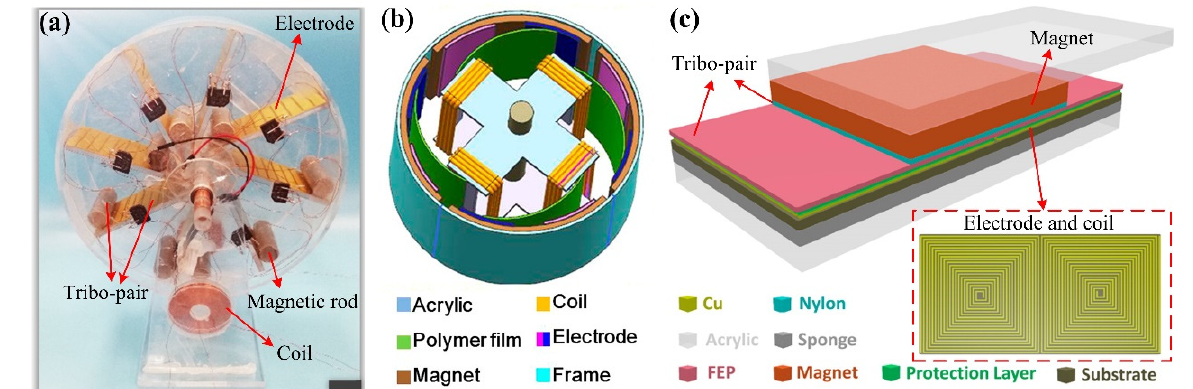
Figure 5. Structures of triboelectric-electromagnetic hybrid generators: ( a ) A waterwheel-like structure with EMG acting as the base (Reproduced with permission [24]. Copyright 2018 Elsevier); ( b ) A wind speed sensor with EMG acting as the base (Reproduced with permission [54]. Copyright 2018 American Chemical Society); ( c ) A SFTENG with EMG integrated into the structure (Reproduced with permission [55]. Copyright 2016 American Chemical Society).